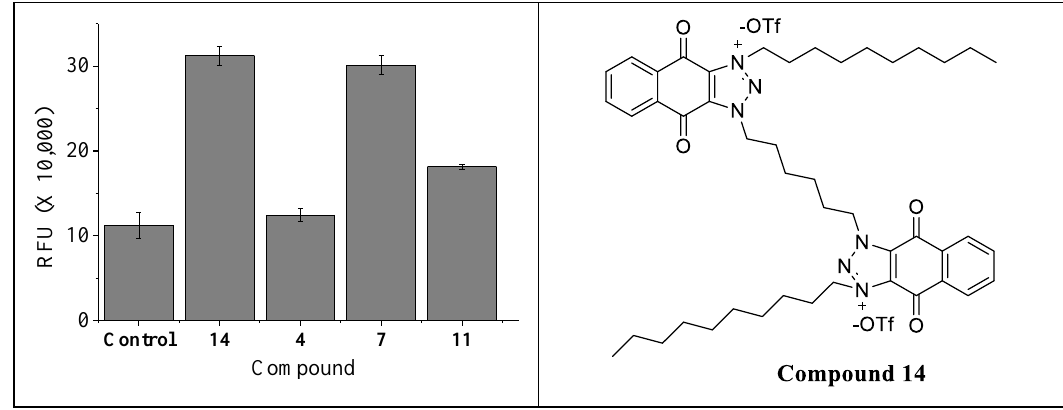
Figure 9. Reactive oxygen species (ROS) study for 4″,6″-disubstituted AKs and compound 14 structure .